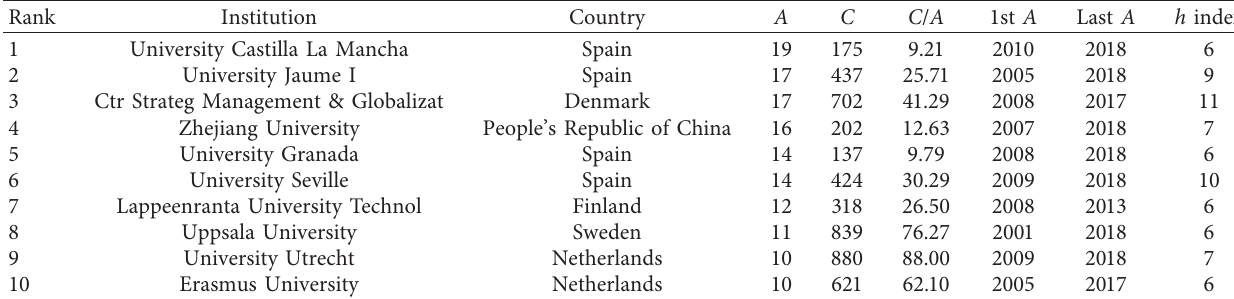
Table 7: Ten most productive institutions.